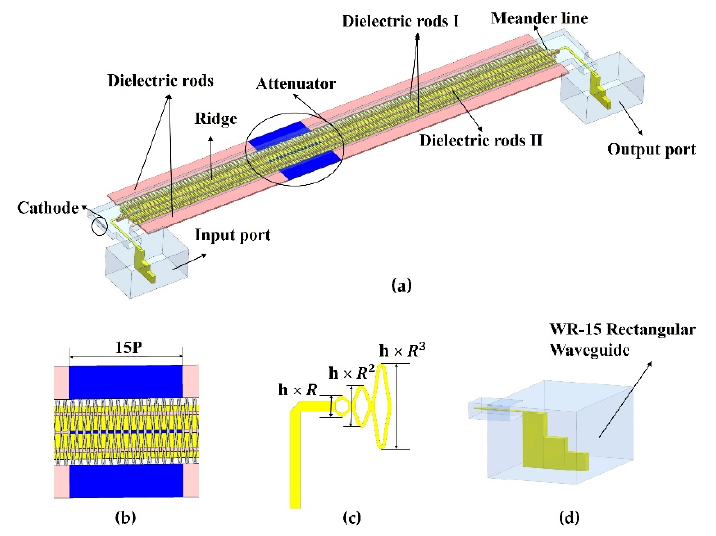
Figure 3. ( a ) The whole MDSRL-RSML SWS structure; ( b ) attenuator section; ( c ) gradient section; ( d ) the input–output couplers of the stepped ridge waveguide transition. The optimized thickness of the dielectric rod І (s2) varies with the number of axial periods as shown in Figure 4.